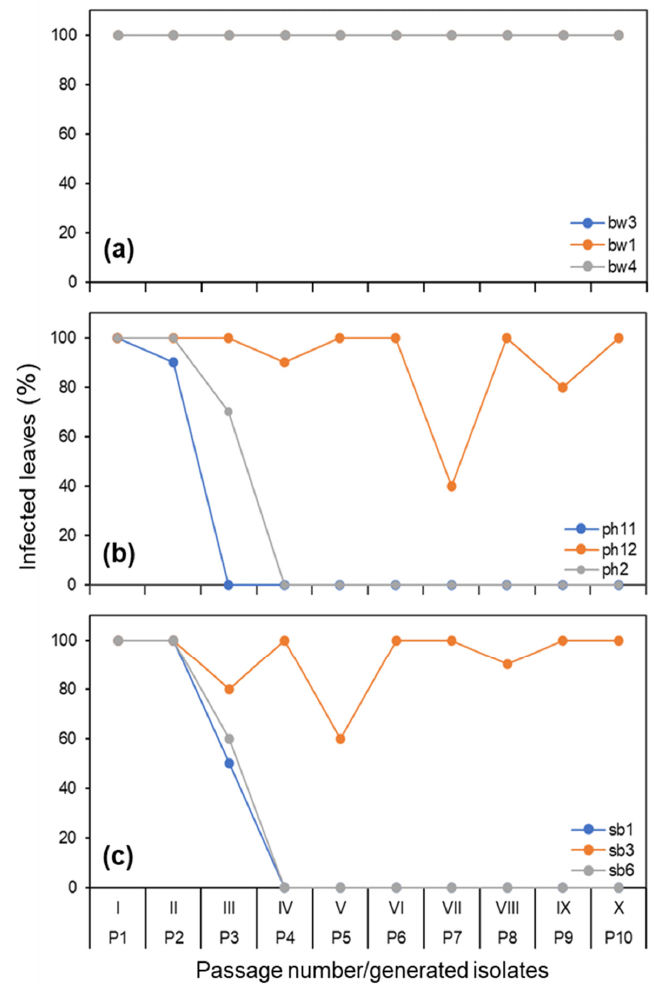
Figure 2. Infectivity of Calonectria pseudonaviculata isolates on their plants of origin, i.e., boxwood ( a ), pachysandra ( b ), or sweet box ( c ), 2 weeks after inoculation in 10 passages (I–X). The lines and dots of bw1 and bw3 are masked due to overlapping with bw4 in ( a ). For each isolate, detached leaves ( n = 10) of an original host plant were inoculated with a drop of conidial suspension from a culture plate (P0) for passage I or from infected leaves of the previous passage I to IX for passages II–X. P1–P10 are the isolates generated in the individual passages. Each point represents an average of the infected leaves.